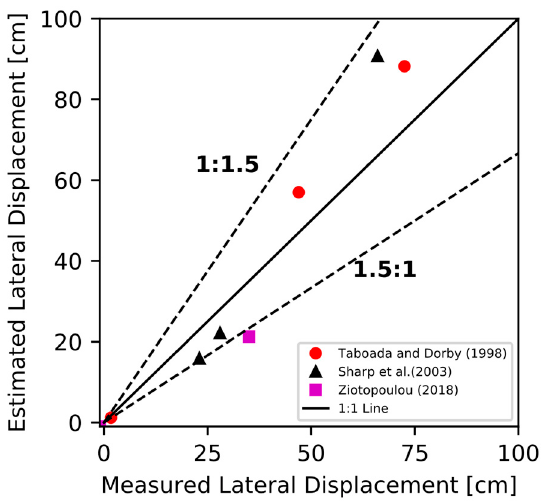
Figure 14. Estimated versus measured lateral displacements using Cyclic1D from selected centrifuge